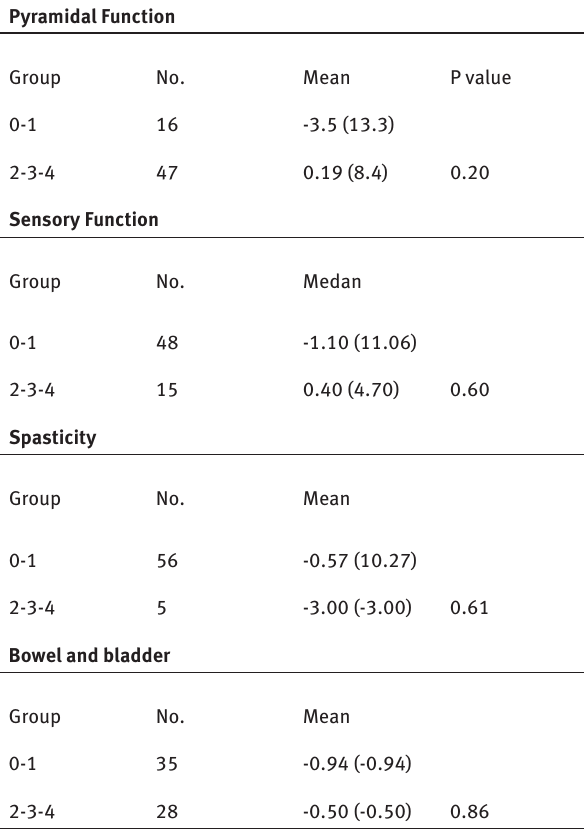
Table 3: Relation between ΔRAP and functional systems on the EDSS.